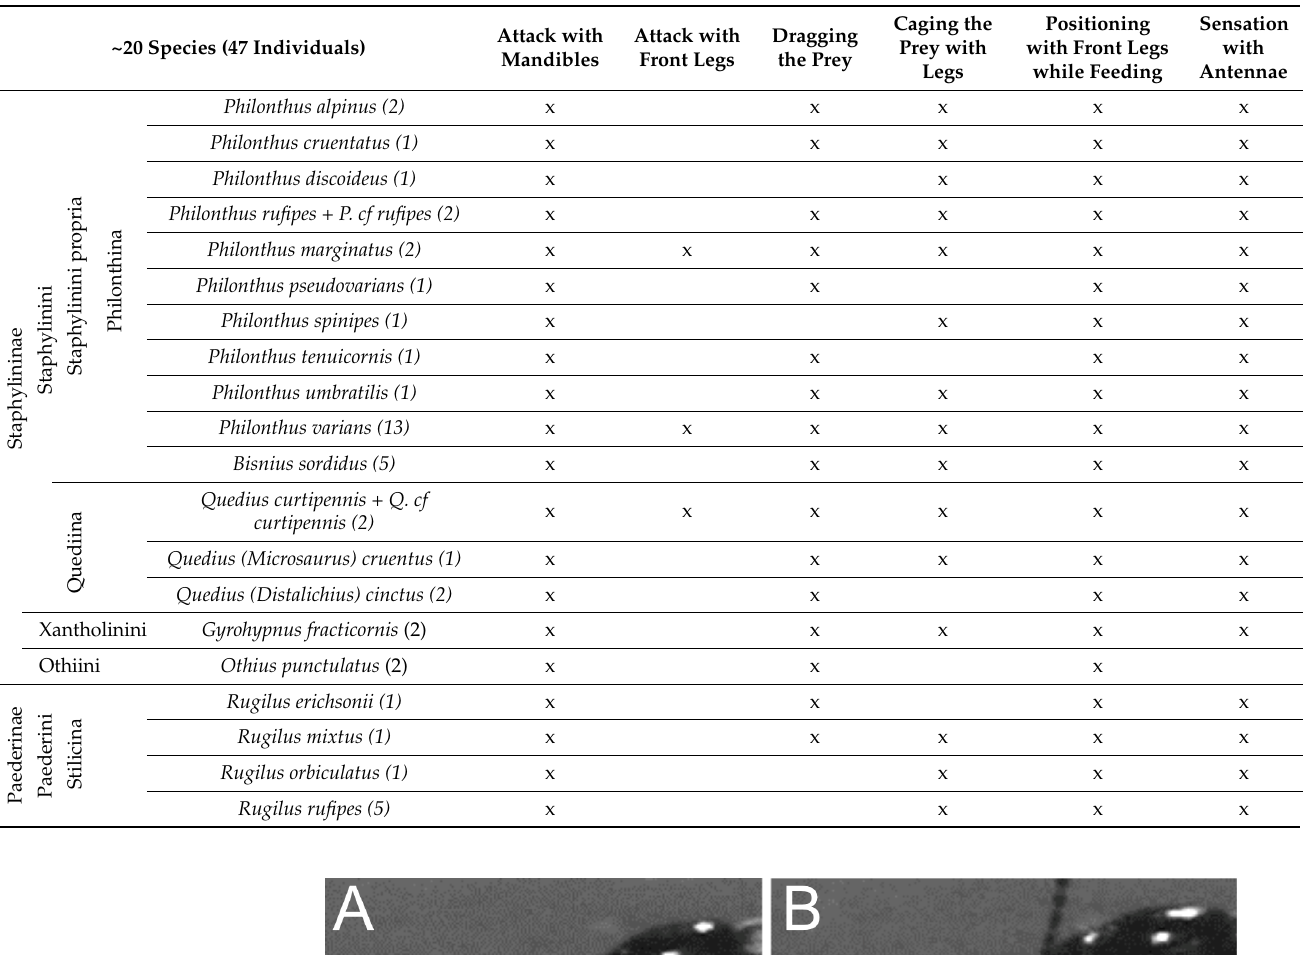
Table 3. Occurrence of behaviours in the various beetle species. The crosses in the table mark which rove beetle species were observed and documented performing the behaviours provided in the columns. The numbers in brackets following the species names show the total number of individuals involved.